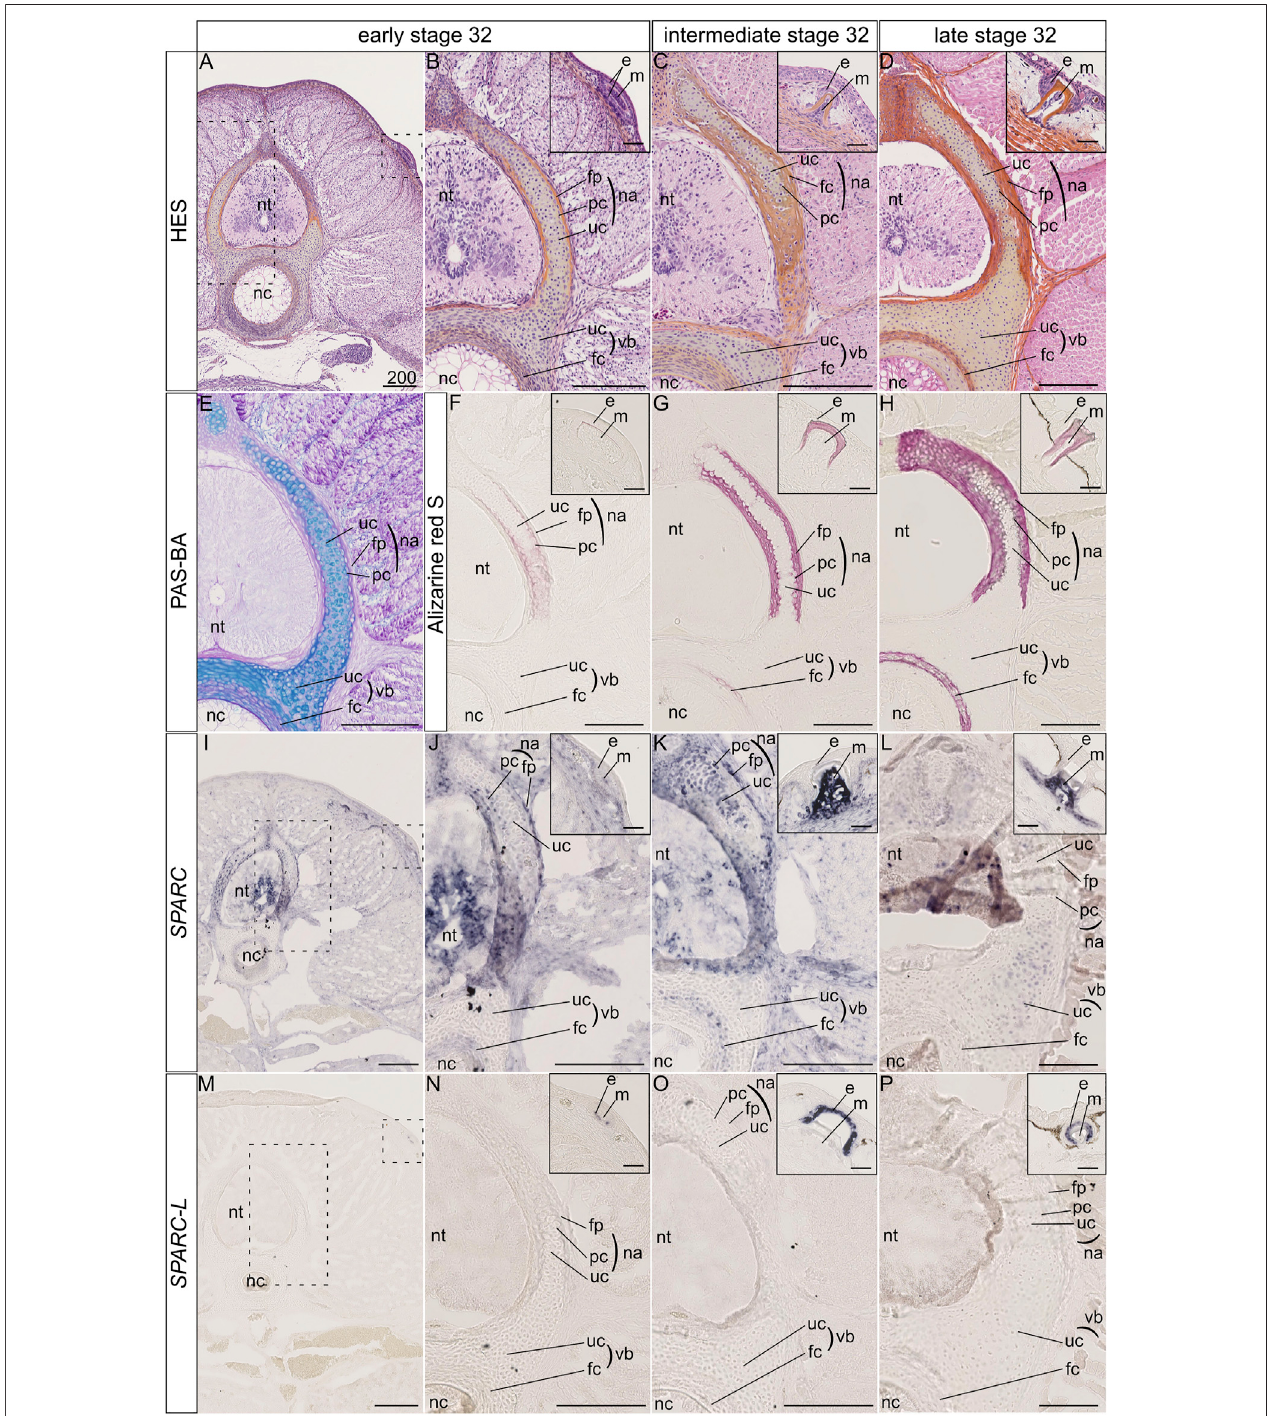
FIGURE 2 | Histology, mineralization dynamics and SPARC and SPARC-L expression pattern in the vertebrae and scales of the small-spotted catshark Scyliorhinuscanicula . (A – D) Hematoxylin-EosinSafran(HES)histologicalstainingontransversesectionsatthelevelofthoracicvertebrae:A,generalviewwithlocationof the neural tube (nt) and notochord (nc); B-D, closer views on vertebral tissues as boxed in A, with identi fi cation of the fi brous perichondrium (fp), unmineralized cartilage (uc) and peripheral chondrocytes (pc) of the neural arch (na), as well as the unmineralized cartilage (uc) and fi brous cartilage (fc) of the vertebral body (vb); insets in B-D,closerviewofthedorsalscalesasboxedinA,indicatingthelocationoftheepithelial(e)andmesenchymal(m)compartmentsofscalebuds.Stage32embryoswere staged according to their total length into “ early, ” “ intermediate, ” and “ late ” categories as described in the Material and Method section. (E) Periodic Acid Schiff-Alcian